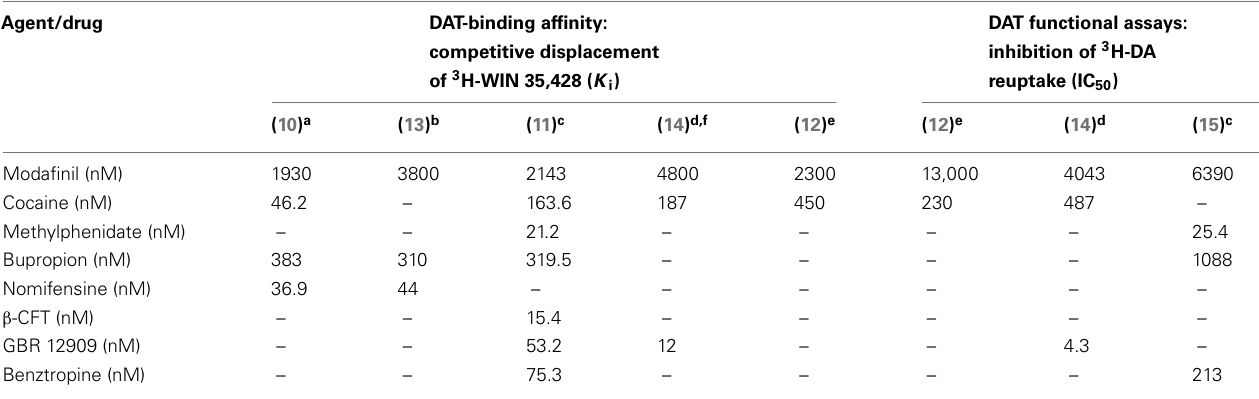
Table 1 |Affinity of modafinil compared to other dopamine reuptake